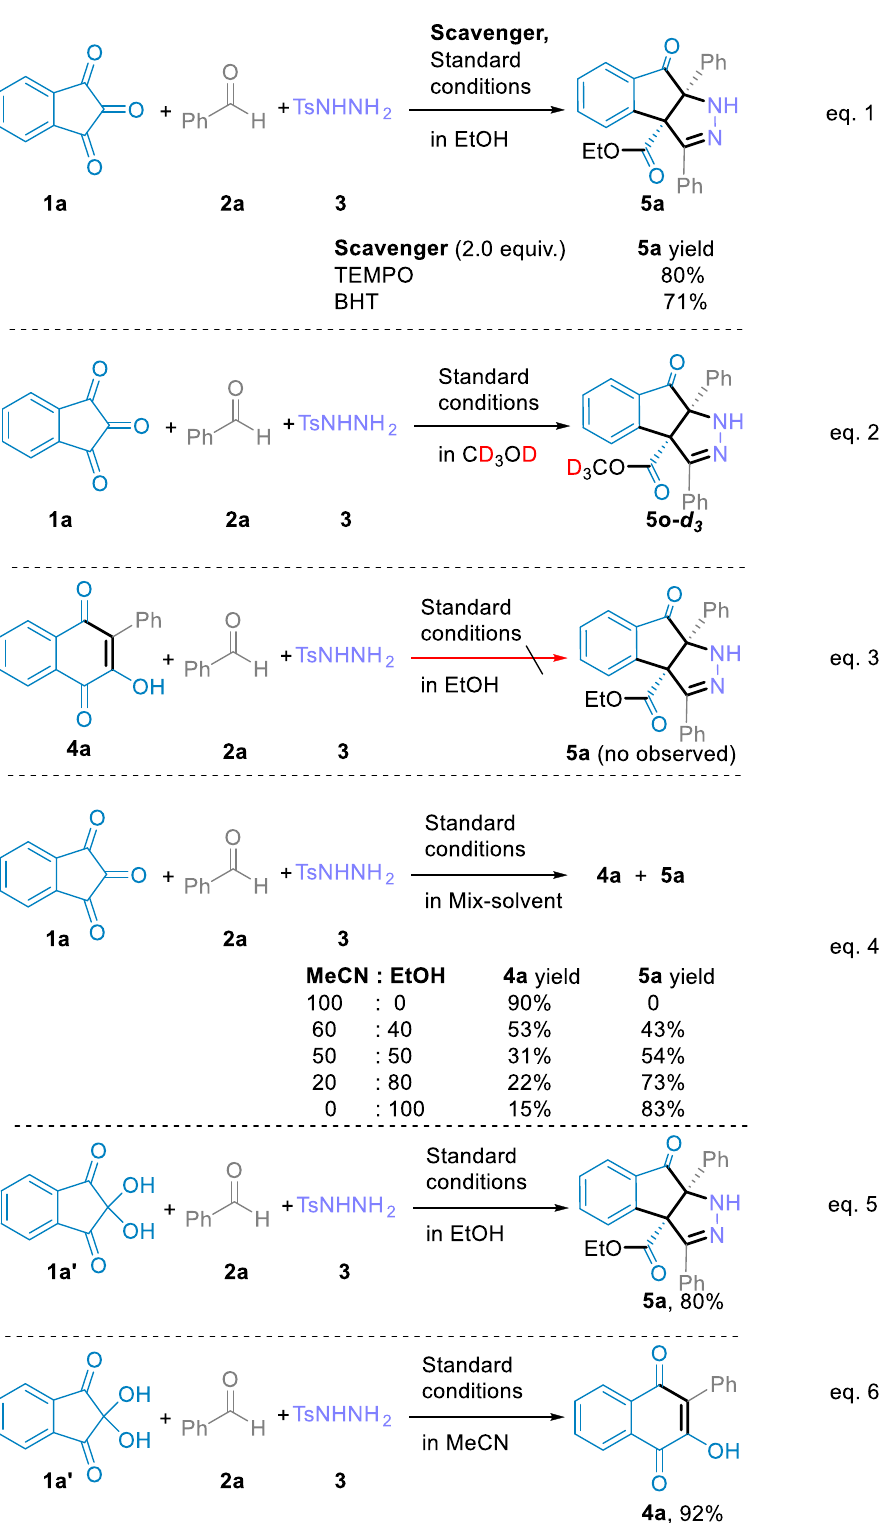
Fig. 5 Control experiments. Free radical capture experiment (eq. 1). Deuterium hydrogen exchange experiment (eq. 2). Standard reaction of intermediate 4 in ethanol solvent (eq. 3). Mixed solvent proportion control experiment (eq. 4). Reaction of ninhydrin hydrate under standard conditions (eqs. 5 and experiments in deuterated methanol showed that the ester group of the various control experiments were conducted (Fig. 5). The results indenopyrazolone product was formed by bonding the C1 atom of indicated that: (1) the addition of TEMPO or BHT did not inhibit the indantrione with deuterated methyl (Fig. 5, eq. 2); (3) using lawsone 4a reaction under standard conditions, and no radical-TEMPO/BHT and α -aryldiazomethane as the starting material in alcohol solution, coupling products were detected (Fig. 5, eq. 1); (2) isotope-labeling